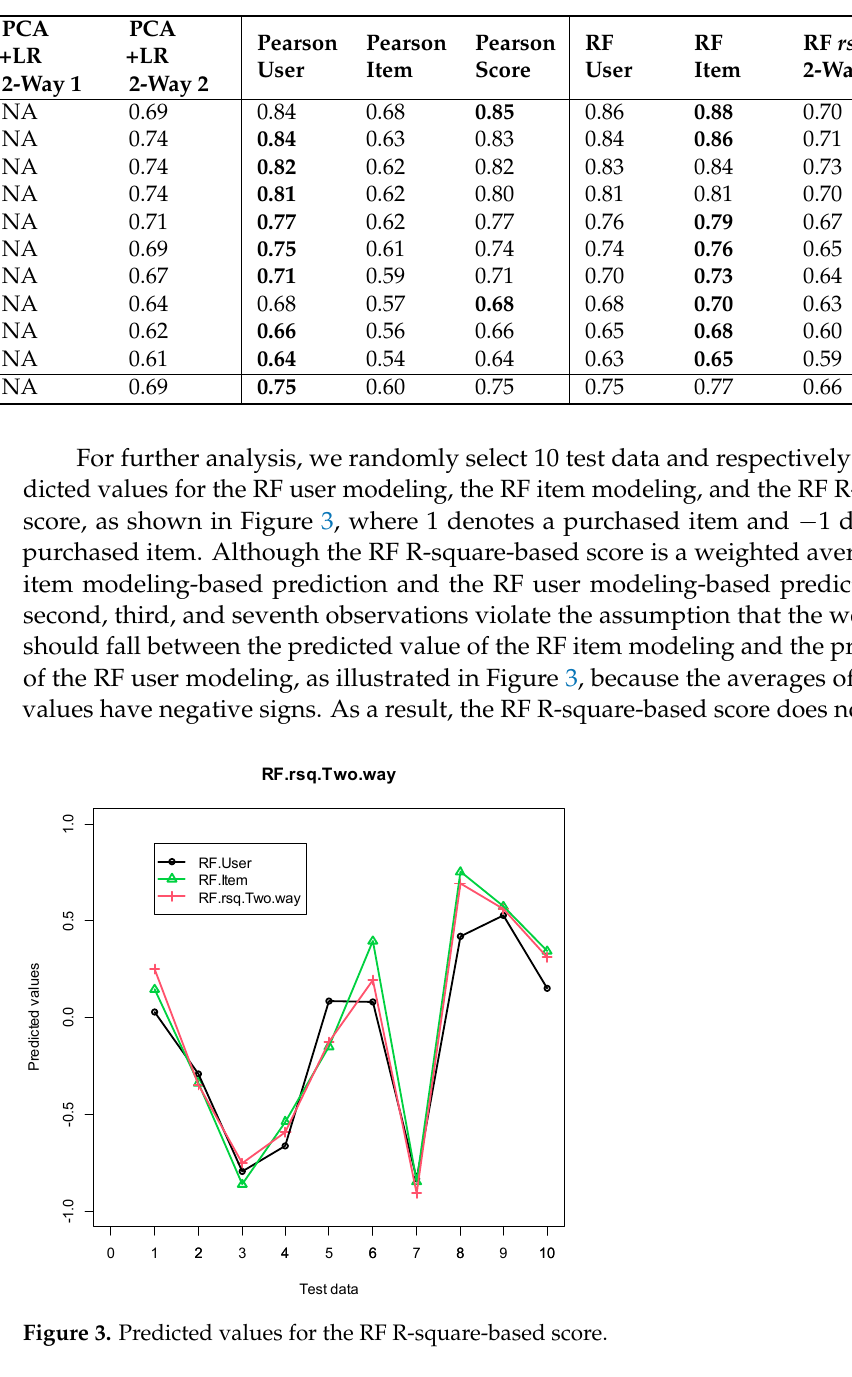
Table 6. Top- N accuracy for case 4.